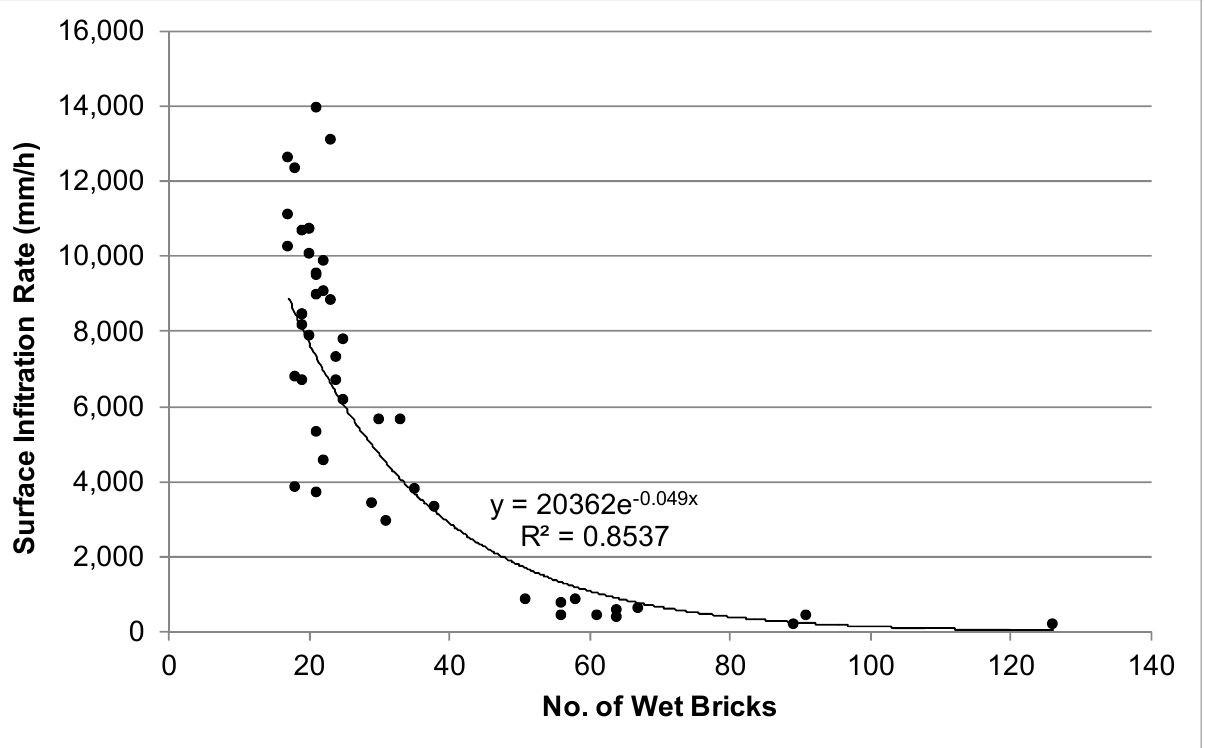
y = 20362e -0.049x R² =